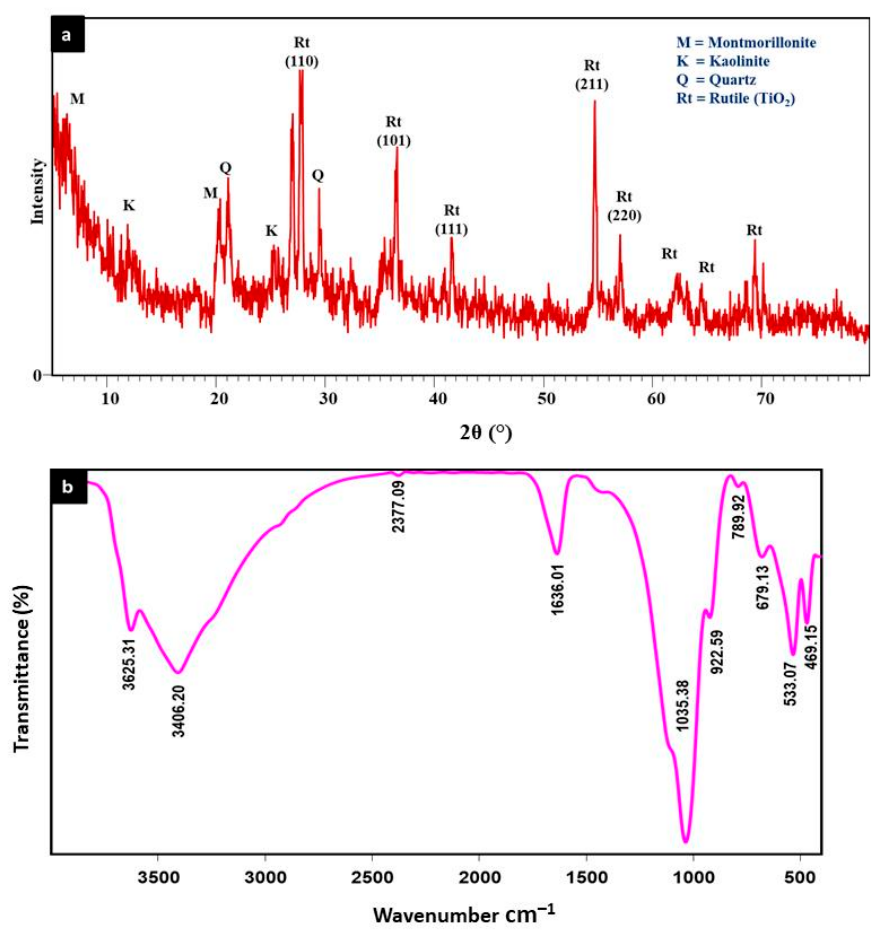
Figure 2. ( a ) XRD pattern and ( b ) FTIR spectrum of Rt/BC material.